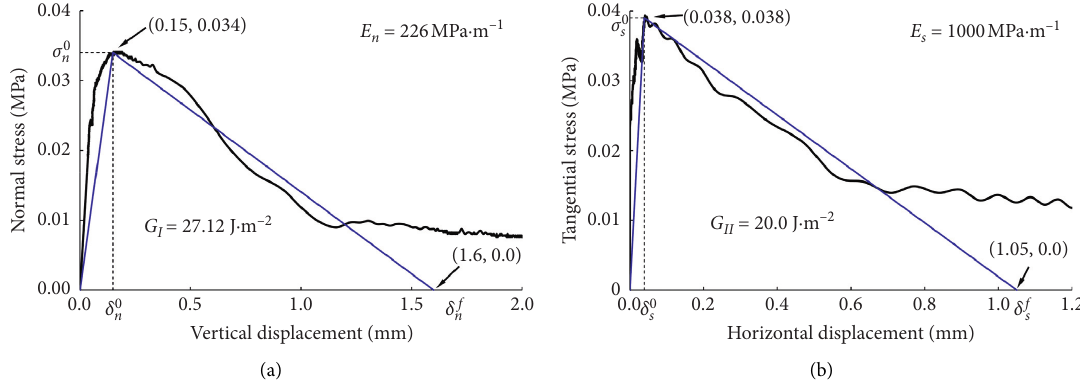
Figure 7: Force-displacement curve of the vertical (a) and horizontal push plate test (b).